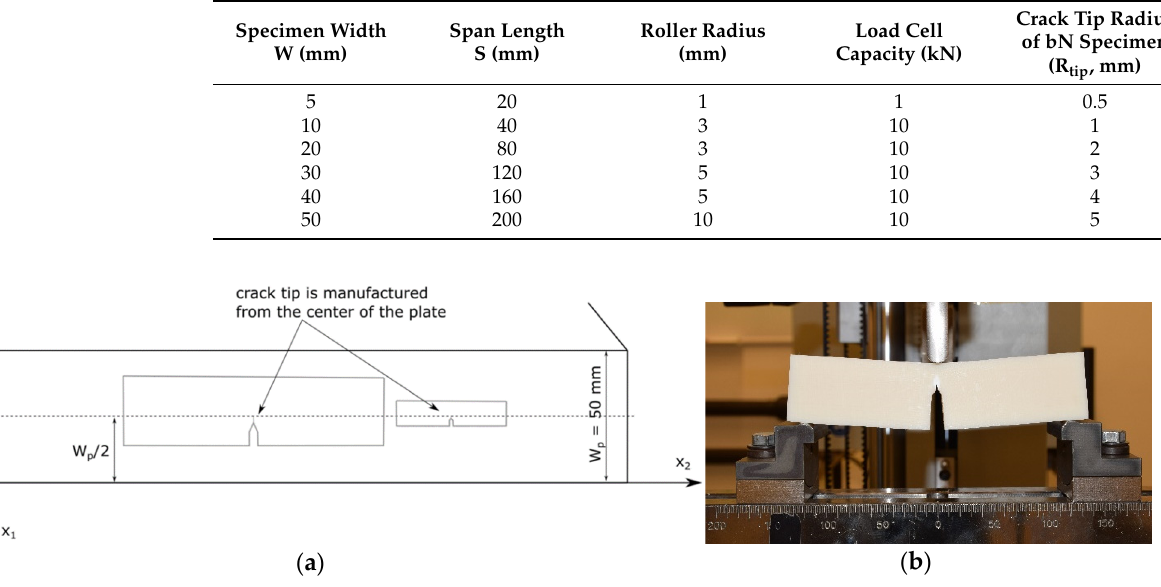
Figure 6. Scheme of the specimen manufacturing from the centre of the ABS plate to assure similar conditions near the crack tip (adapted from [7] with permission) ( a ); sN SENB specimen during testing ( b ).